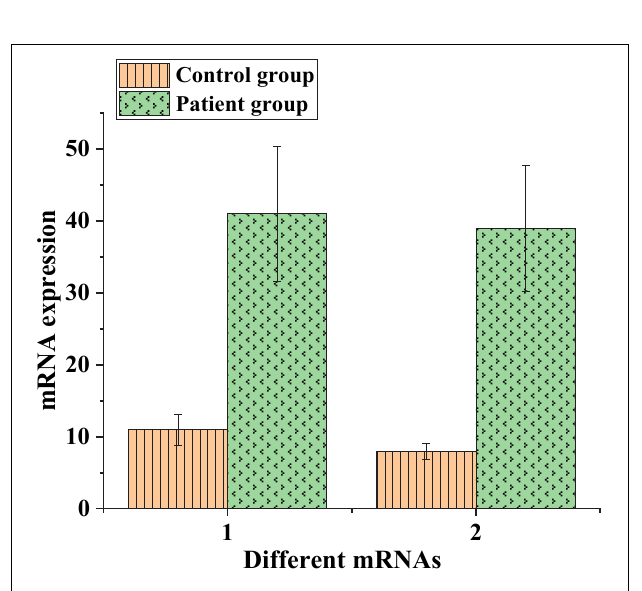
FIGURE 9 | The expression of messenger RNA corresponding to CCNB1 and TOP2A proteins in the control and experimental groups (1: CCNB1; 2: TOP2A).